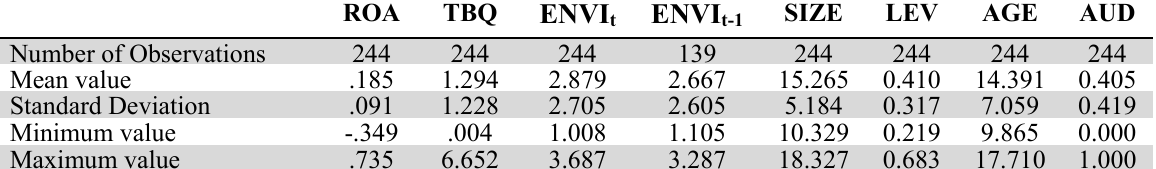
Statistical Analysis